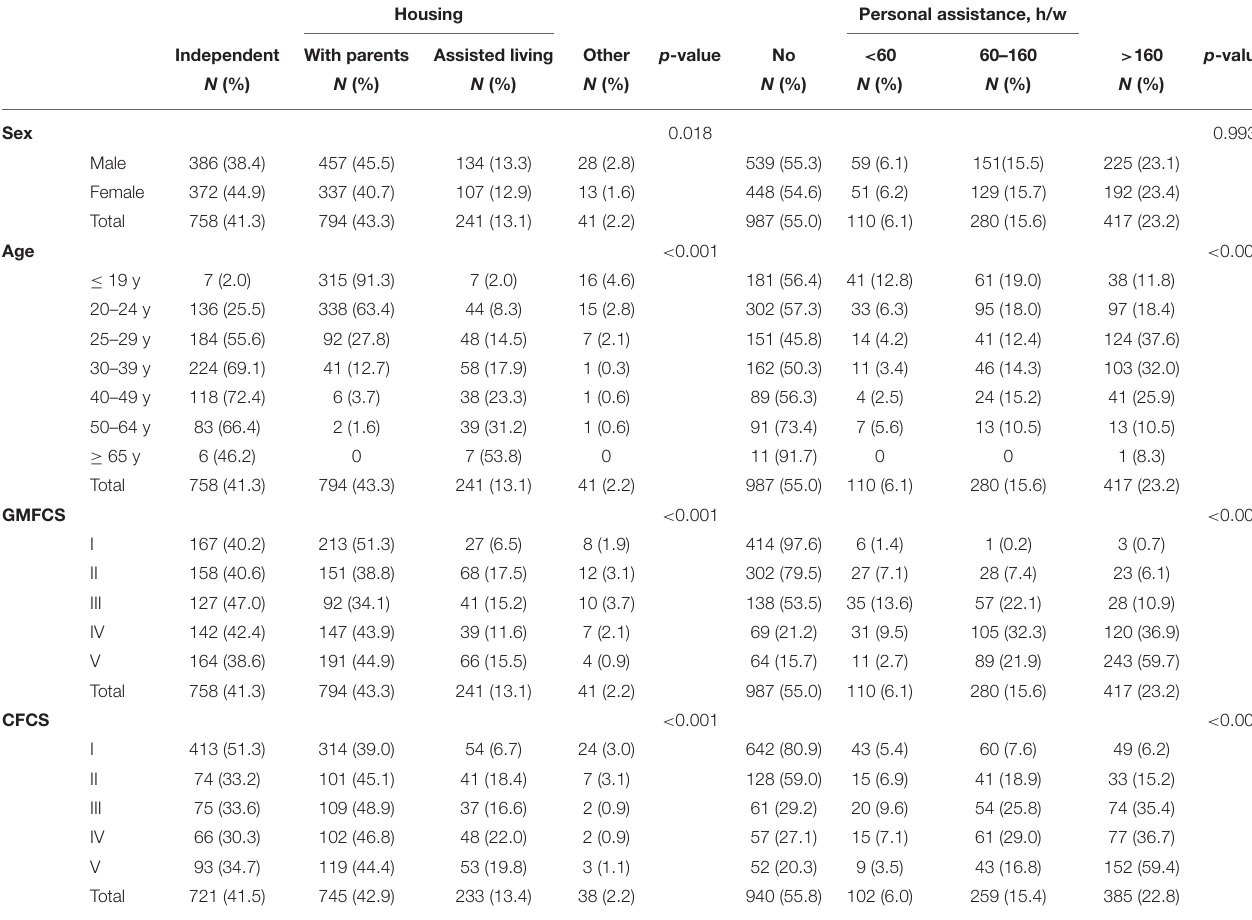
TABLE 4 | Type of housing and personal assistance (hours/week) for all adults relative to their sex, age, GMFCS and CFCS